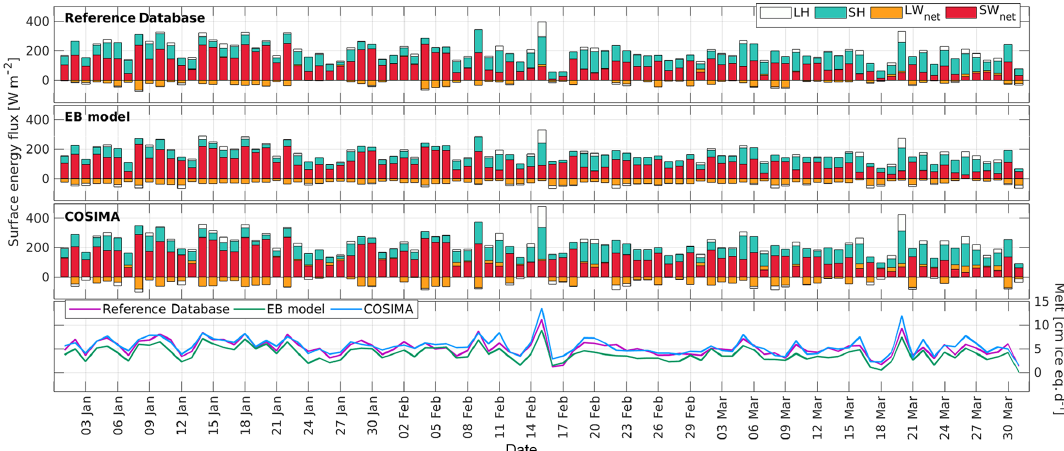
Figure 8. Daily modeled and measured energy fluxes and melt during summer 2016 for Tyndall Glacier using the three methods.